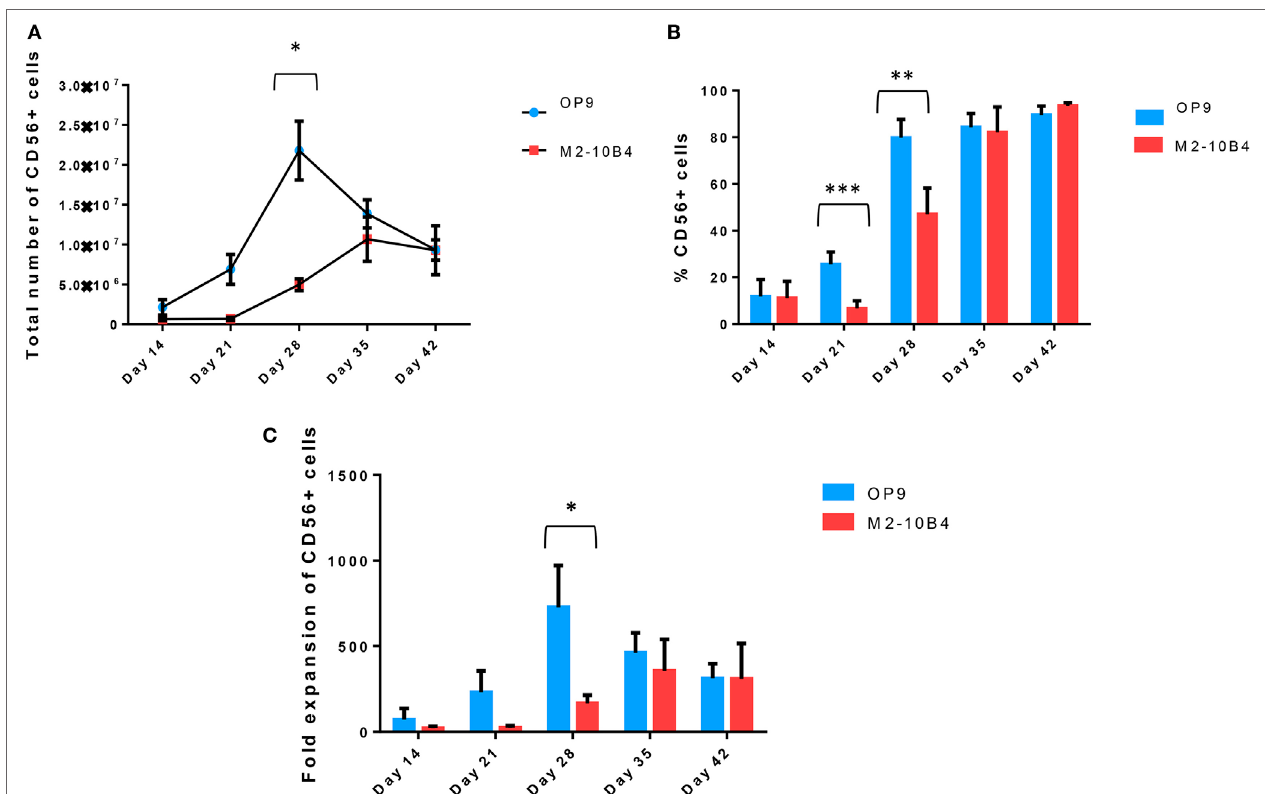
FigUre 1 | (a) Total number of CD56 + cells at different time points during the in vitro differentiation protocol with the two different culture conditions: OP9 and M2-10B4 cells coculture. (B) Percentage of CD56 + cells at different time points of the differentiation protocol with the two different culture conditions: OP9 and M2-10B4 cells coculture. (c) Fold expansion of the CD56 + cells regarding the initial number of CD34 + cells plated in each experiment ( n = 4). The bars represent the mean and error bars represent SEM. p -Value: * p < 0.05, ** p < 0.005, and *** p < 0.001. The absence of any asterisk indication means there are no significant